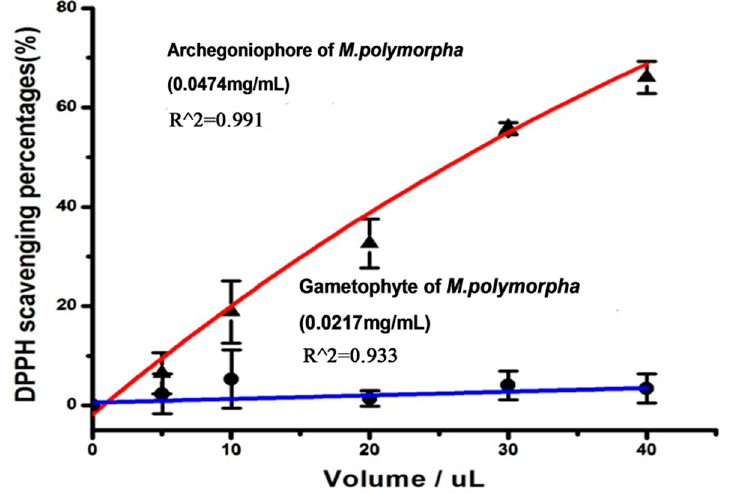
Figure 2. The DPPH free radical scavenging potential of the gametophyte and archegoniophore of M. polymorpha L. ( n = 3).